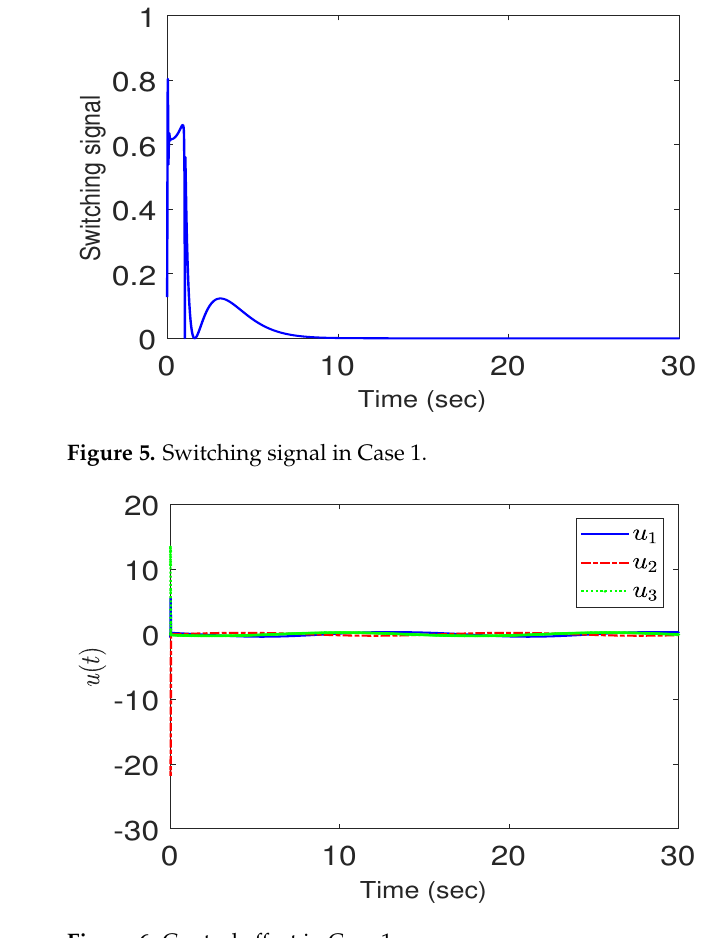
Figure 8. Control effort in Case 2 avoiding the tedious procedure of determining the regression matrices. Extension to 209